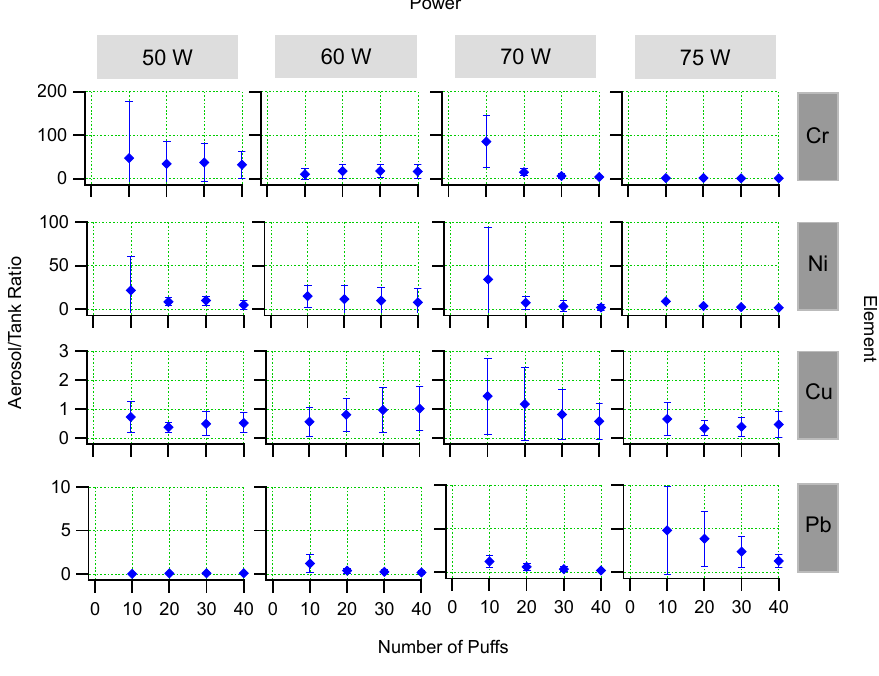
Figure 5. Aerosol/tank concentration ratio plotted for each element, power, and number of puffs. The error bars represent standard deviations of repeated puffing